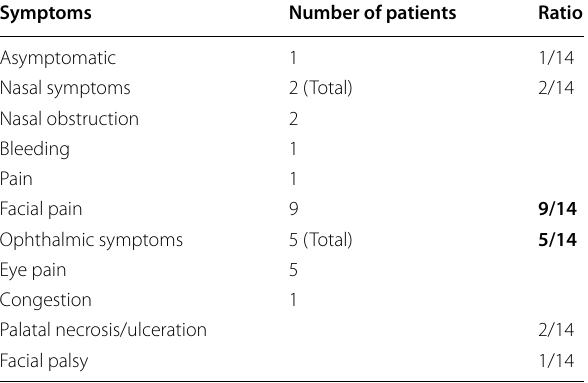
Bold values indicate the symptoms with highest frequency in mucormycosis patients